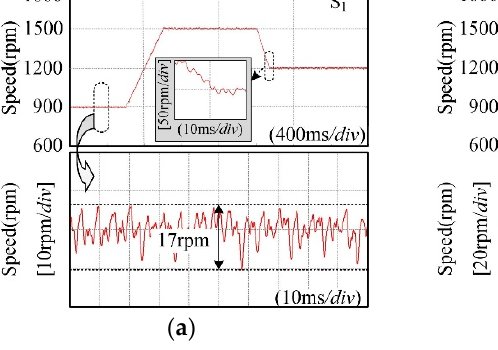
Figure 18. ( a ) Speed trajectory of S 1 ; ( b ) Speed trajectory of S 2 ; ( c ) Speed trajectory of S 3 .